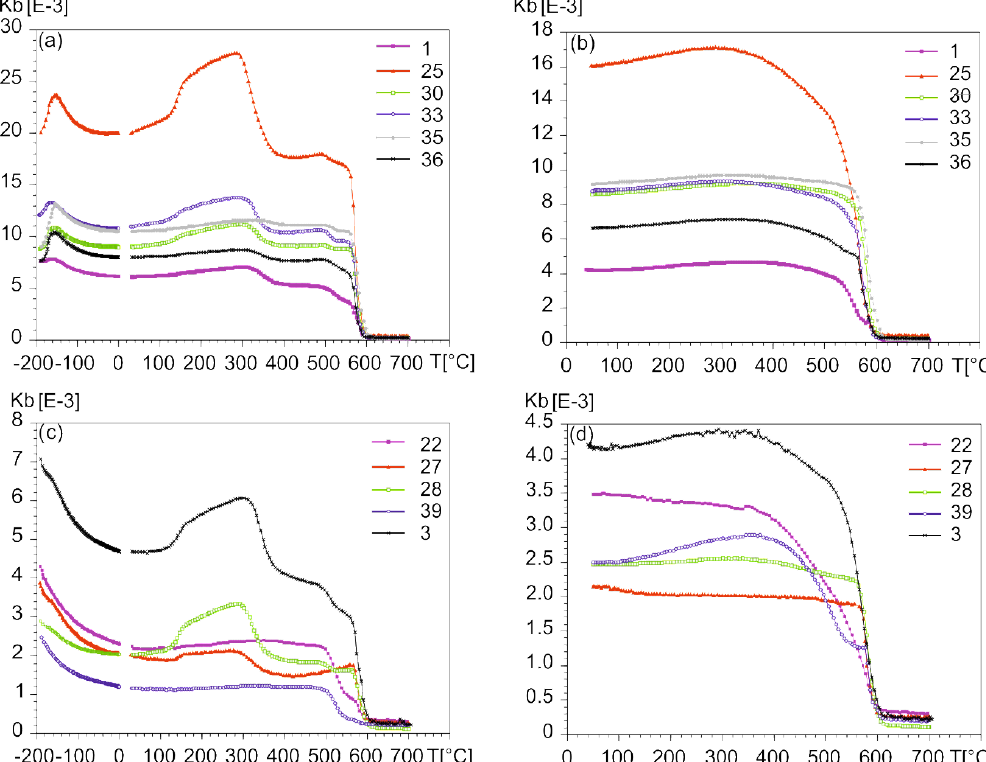
Figure 4. Susceptibility vs. temperature curves for pilot specimens. ( a ) Heating curves for specimens showing Verwey transitions in low-temperature segments, ( b ) cooling curves for the same specimens, ( c ) heating curves for specimens showing paramagnetic hyperbola in the low-temperature segment, ( d ) cooling curves for the same specimens. Geosciences 2018 , 8 , x FOR PEER REVIEW